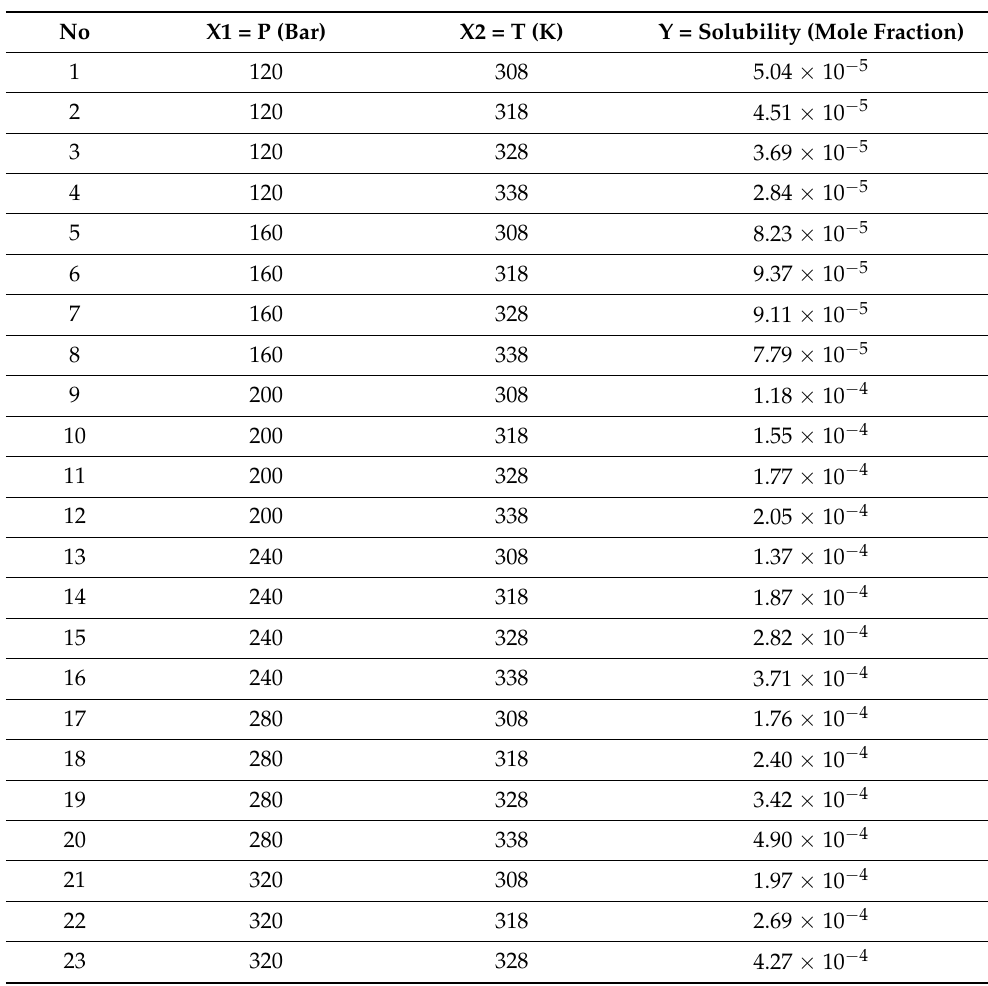
Table 1. The whole